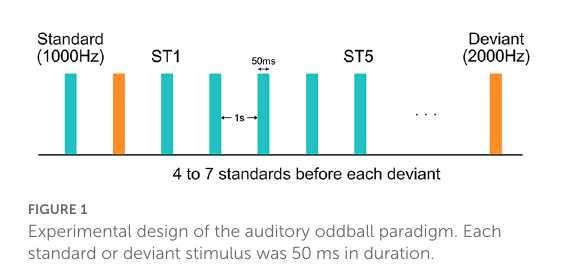
FIGURE1 Experimental design of the auditory oddball paradigm. Each standard or deviant stimulus was 50 ms in duration. Inter-stimulus interval was 1 s. The first and the fifth standard stimuli after each deviant stimulus were deemed as the “ST1” and the “ST5” conditions,